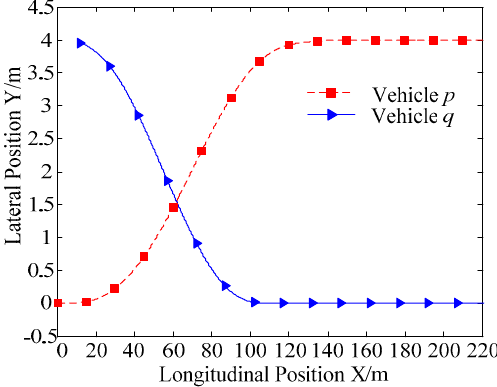
Figure 13. Trajectories of vehicle p and vehicle q . Sensors 2020 , 18 , x FOR PEER REVIEW